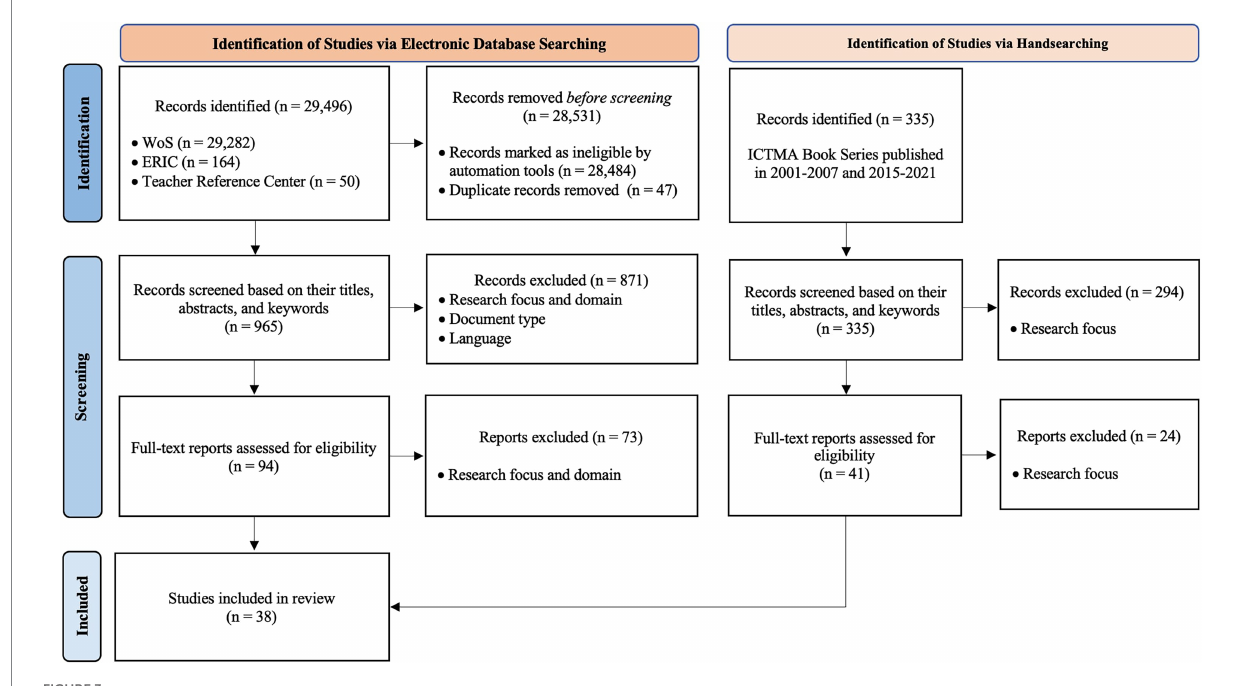
FIGURE 3 Flow diagram of the manuscript selection